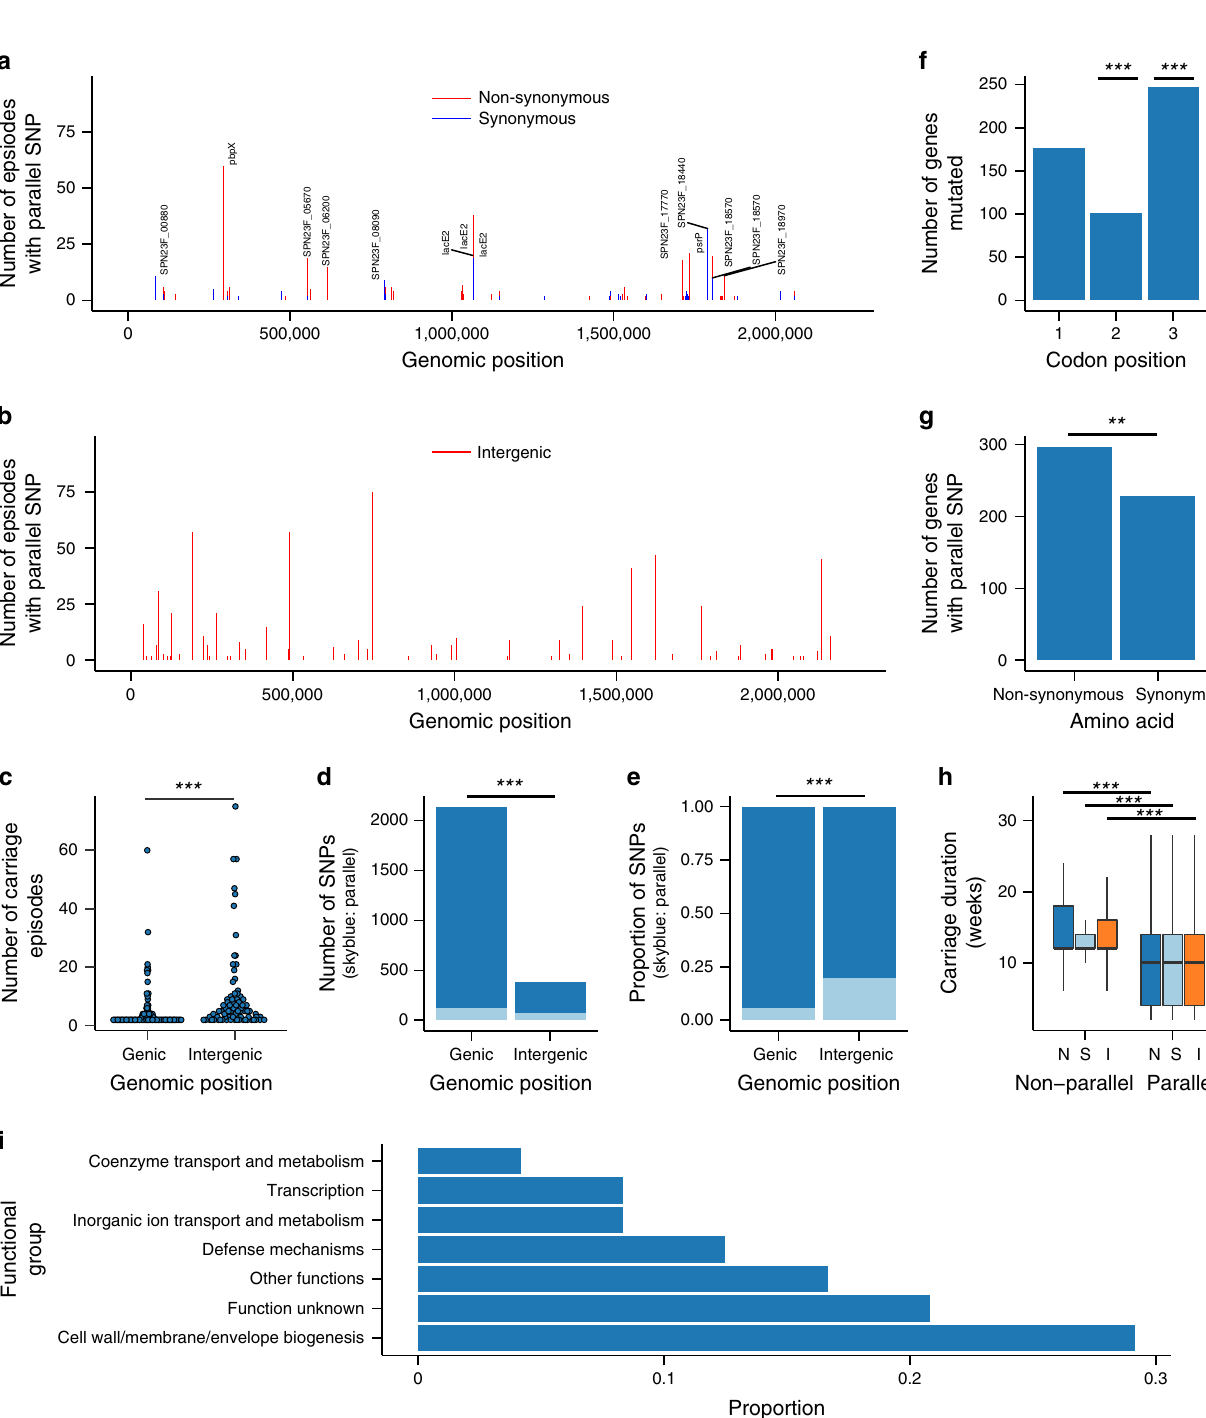
Fig. 6 Parallel genic and intergenic SNPs identi fi ed during colonisation. a Bar plot showing coding or genic regions containing synonymous (red) and non-synonymous (blue) SNPs in the genome. b Bar plot similar to ( a ) but showing genomic regions with intergenic SNPs. c The number of episodes containing a genic or intergenic SNP. d Bar plot showing number of episodes containing a genic and intergenic SNP. e Proportion of episodes with parallel SNPs (dark blue) in genic and intergenic SNPs. f Number of episodes with synonymous and non-synonymous amino acid change in coding regions. g Number of colonisation episodes with a change at each codon position. h Carriage duration of episodes with parallel and non-parallel SNPs. The letters N, S and I stand for non-synonymous, synonymous and intergenic SNPs respectively. The number of data points for each group were as follows: N and non- parallel ( n = 927), S and non-parallel ( n = 1088), I and non-parallel ( n = 311), N and parallel ( n = 297), S and parallel ( n = 228), and I and parallel ( n = 790). i Functional classi fi cation of genes with parallel SNPs. Only episodes with >3 sequenced genomes were included in the analysis. The statistical signi fi cance is shown by the number of asterisks as follows: ** P < 0.01, *** P <